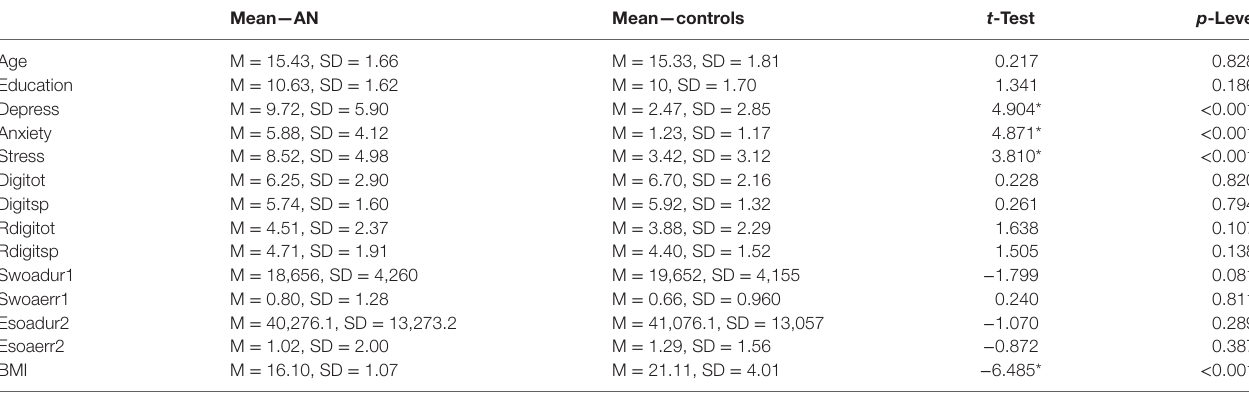
Table 1 | The table reports the means and the t -test scores for the examined clinical and cognitive affective performance associated to AN and control participants. Mean—an Mean—controls t